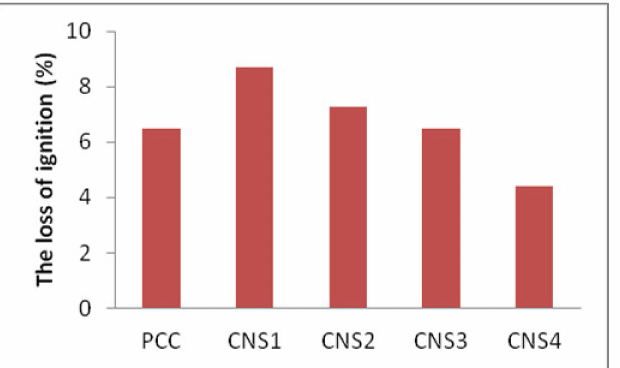
Figure 5. The effect of Napa soil usage on the loss of ignition